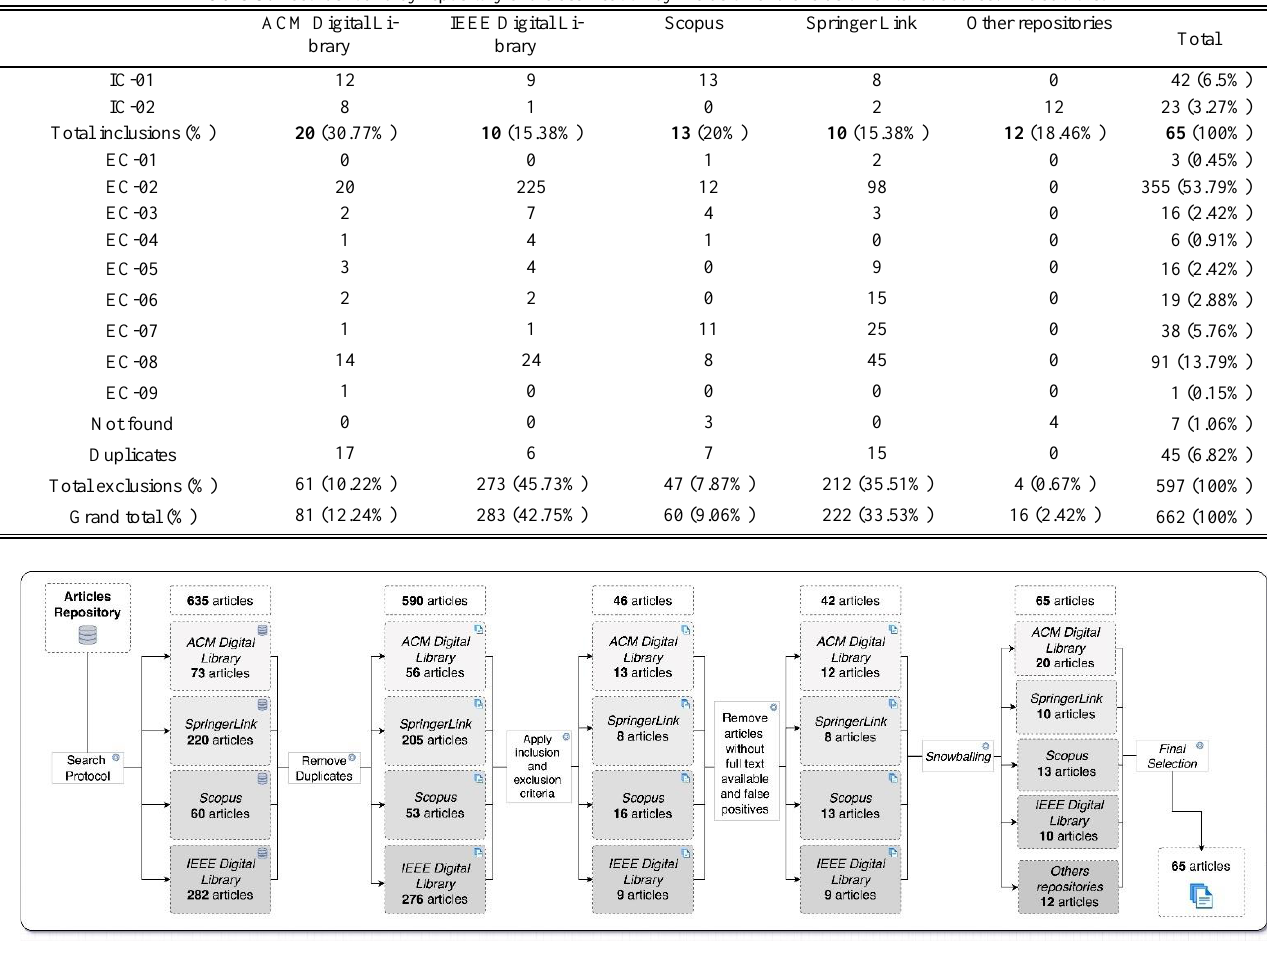
Table 3. Records found by repository and classification by inclusion and exclusion criteria. Source: The authors.